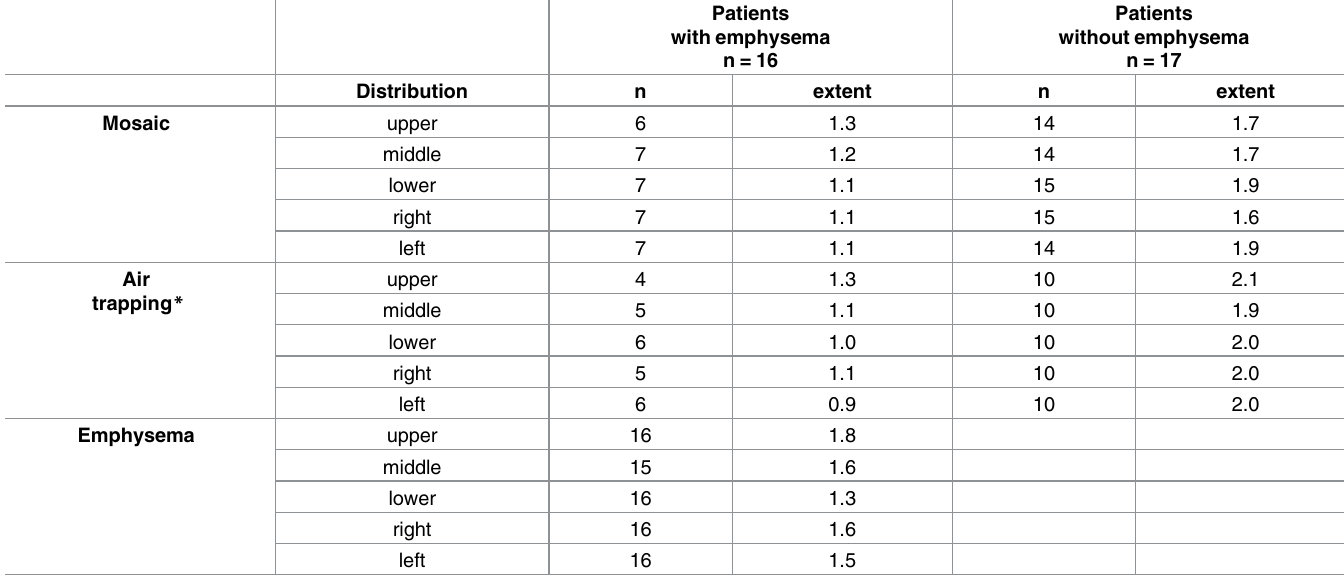
Table 2. Distribution and extent of small airways CT findings.